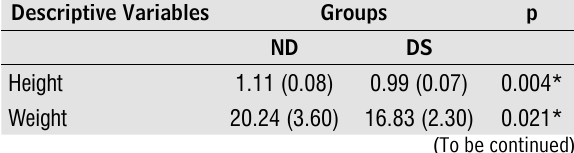
Table 1 – Mean Scores and standard deviation obtained for descriptive variables in the t-test, between groups DS and